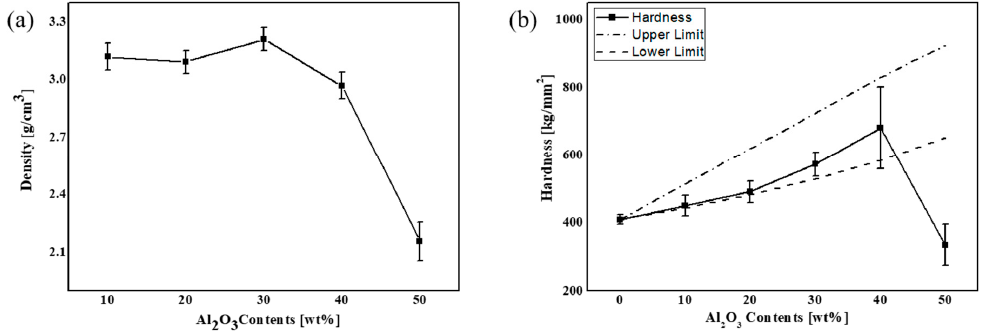
Figure 8. ( a ) Density and ( b ) hardness of sintered glass mixed with Al 2 O 3 as functions of Al 2 O 3 content. Table 2. Theoretical and experimental densities of